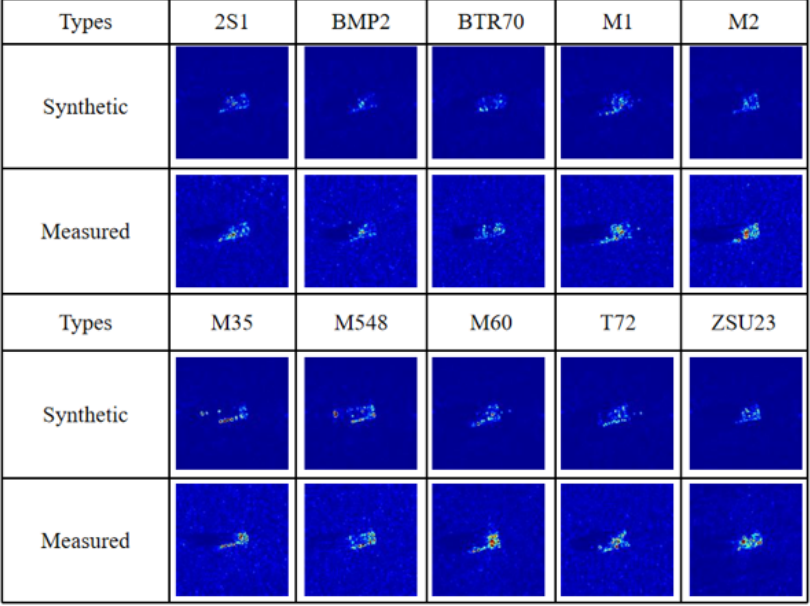
Figure 7. Synthetic data and corresponding measured data of SAMPLE